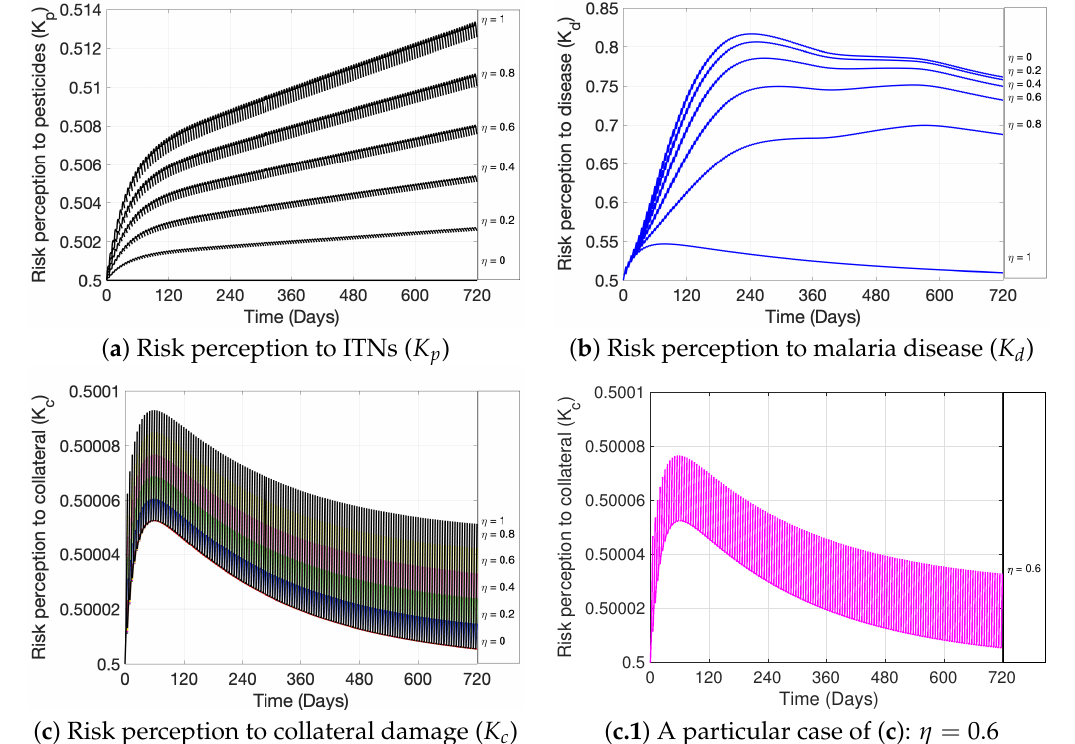
Figure 6. The figure shows, for the values of ITNs coverage η = 0,0.2,0.4,0.6,0.8,1, its effect on the dynamics of ( a ) risk perception to toxicity of ITNs, K p ; ( b ) risk perception to malaria disease, K d ; ( c ) risk perception to collateral damage due to misuse of ITNs, K c ; ( c.1 ) is a particular case of ( c ), picturing risk perception to collateral for η = 0.6. All other parameter values used are as in Figure 4. Figure 7 shows the effect of different risk perception levels on (a) the cumulative cases of chronic intoxications after exposure to ITNs, (b) the proportion of malaria-infected individuals, and on (c) the collateral damage ( D c ) on the ecosystem from misuse of ITNs as fishing gear. The risk perception was changed, making a decimal variation to the resistance to change parameter ( λ 1 ) and the parameter ( λ 2 ) that represents the reaction speed of people against the threat in each risk case. It is observed that after decreasing the resistance to change ( λ p ) and increasing the reaction speed ( λ p ), there is a significant decrease in 2 1 the cumulative cases of chronic intoxications after exposure to ITNs (see Figure 7a). A significant decrease can also be observed regarding the number of